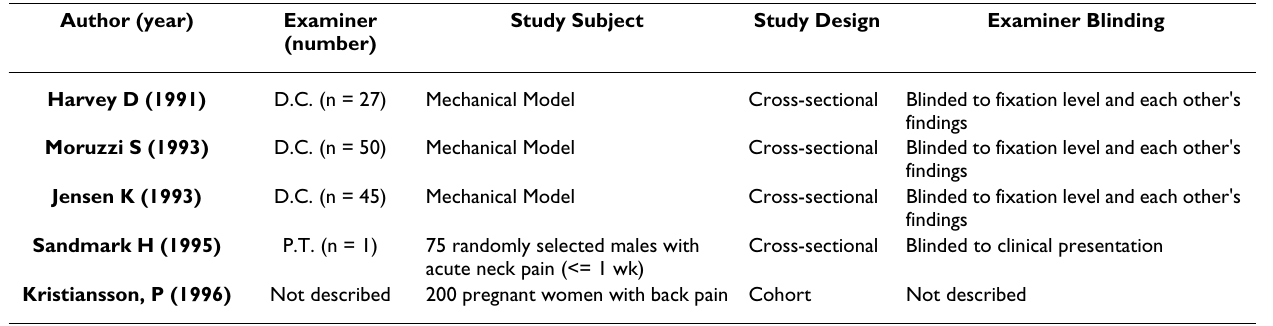
Table 3: Included studies: details Examiner / Subject / Design / & Examiner blinding Author (year)